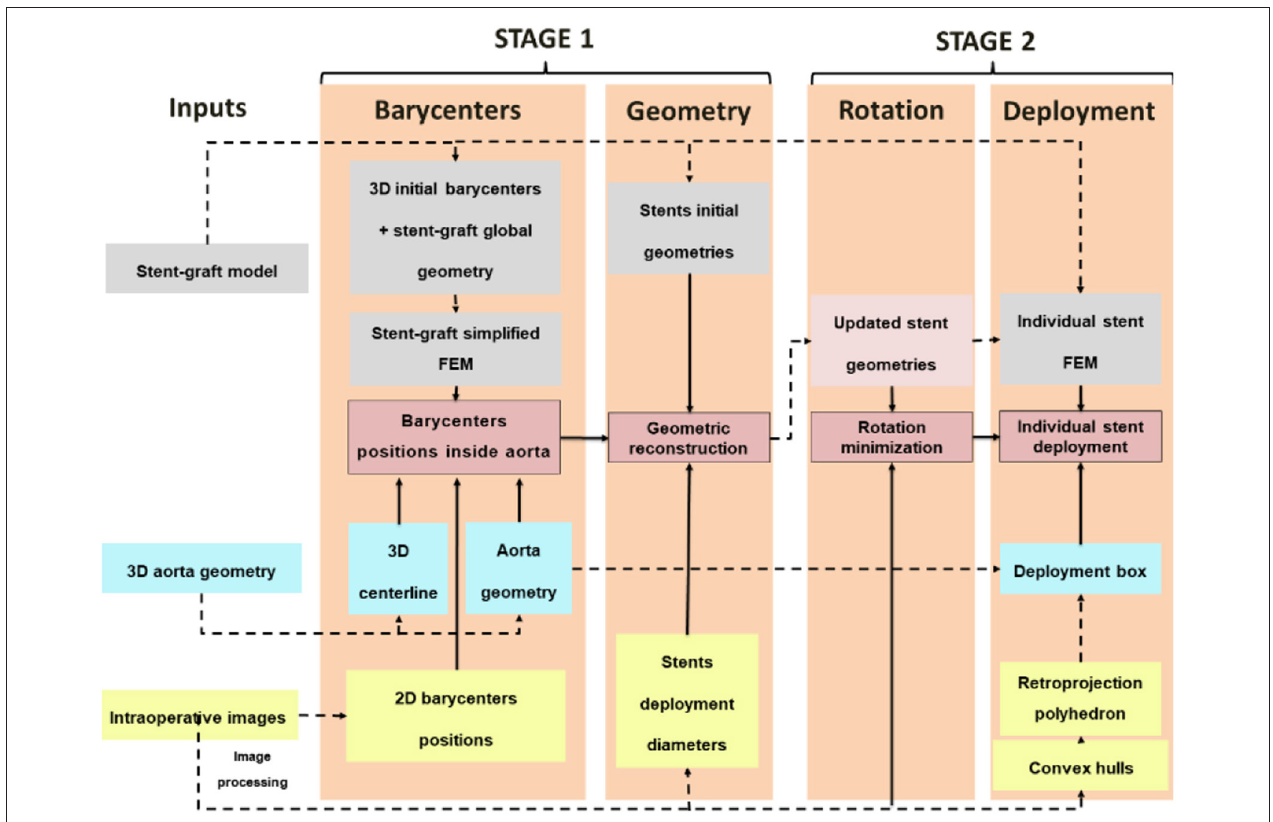
FIGURE 1 | Summary of the algorithm of